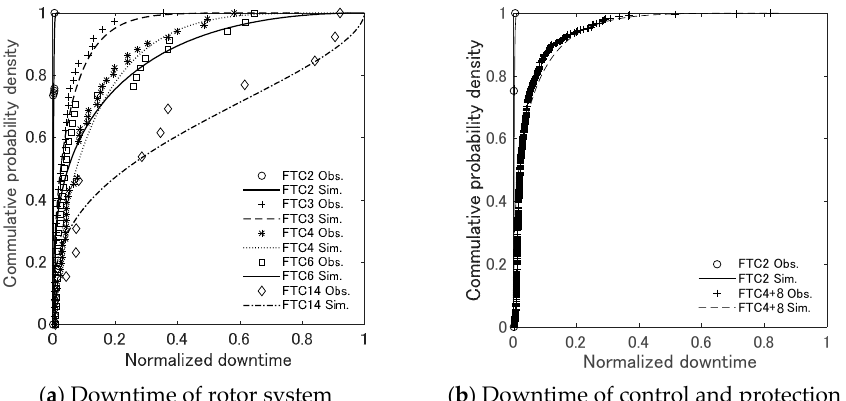
Figure 8. Cumulative distribution of downtime for rotor and control systems.